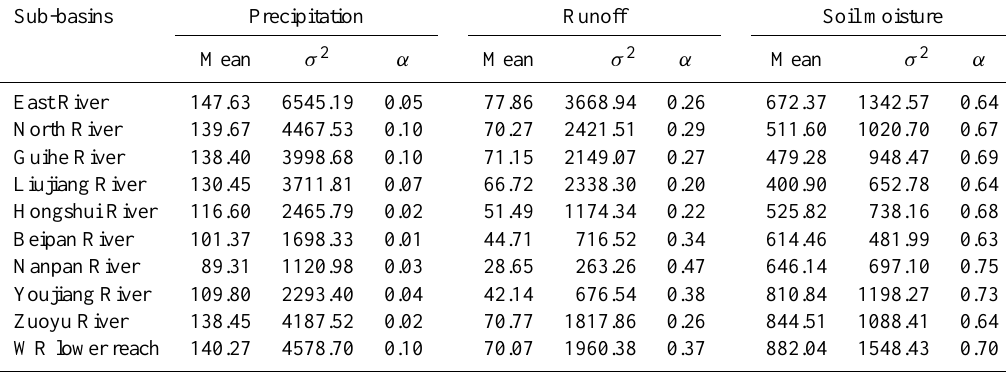
Table 2. Statistical properties of the observed precipitation and the simulated monthly time series (1952–2000) of 10 sub-basins over the Pearl River basin.